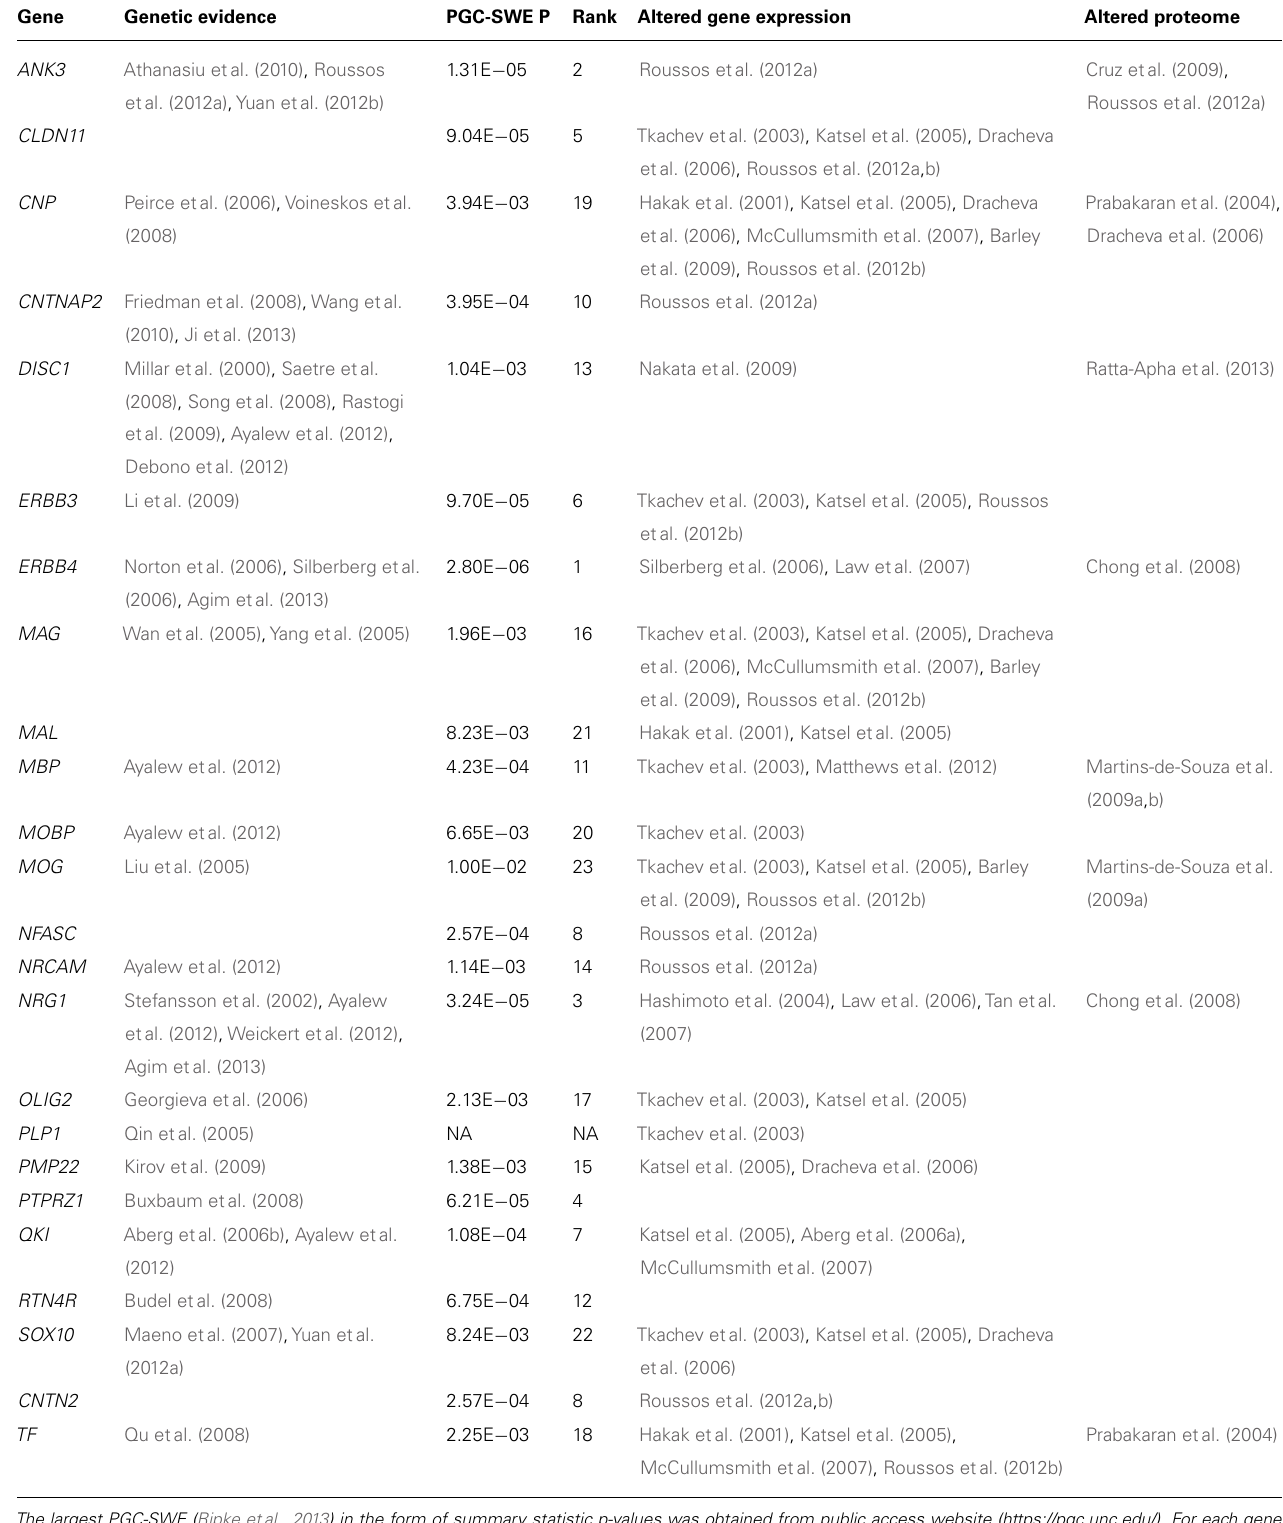
Table 1 | OMR genes implicated in schizophrenia.